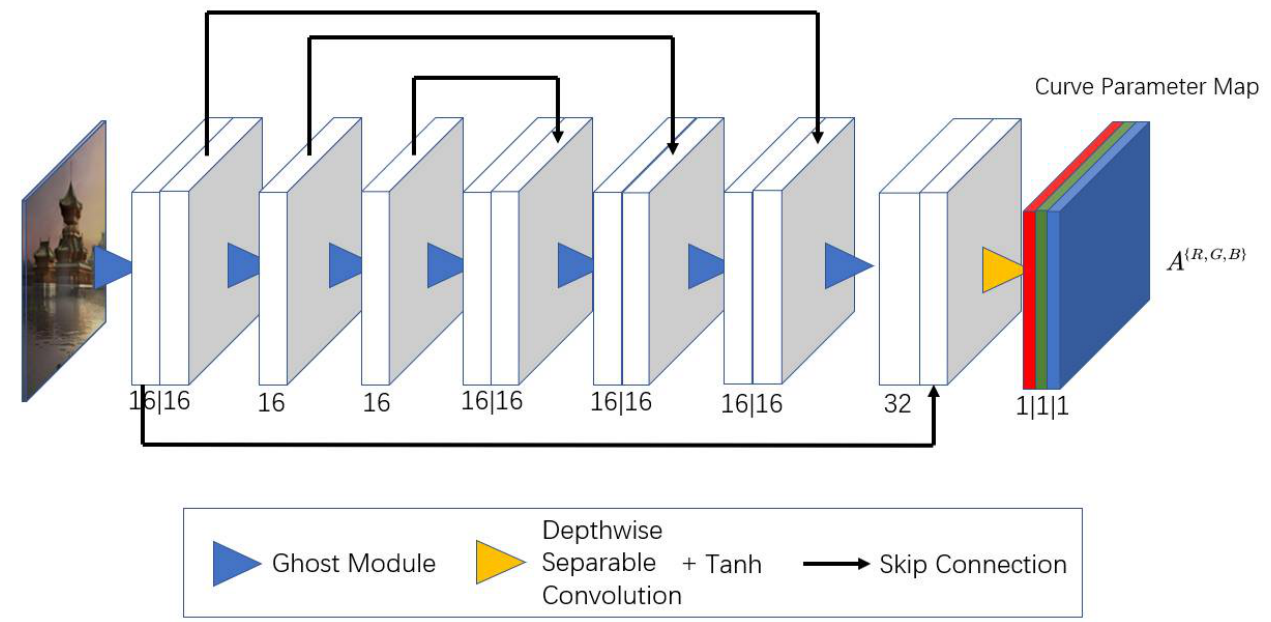
Figure 2. Zero-DCE Tiny structure diagram.